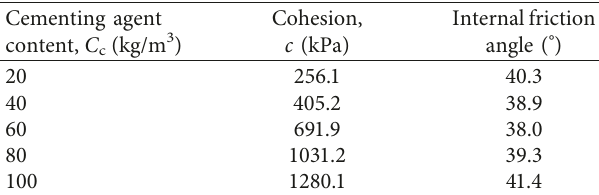
Table 4: Cohesion and internal friction angle under different cementing agent contents.